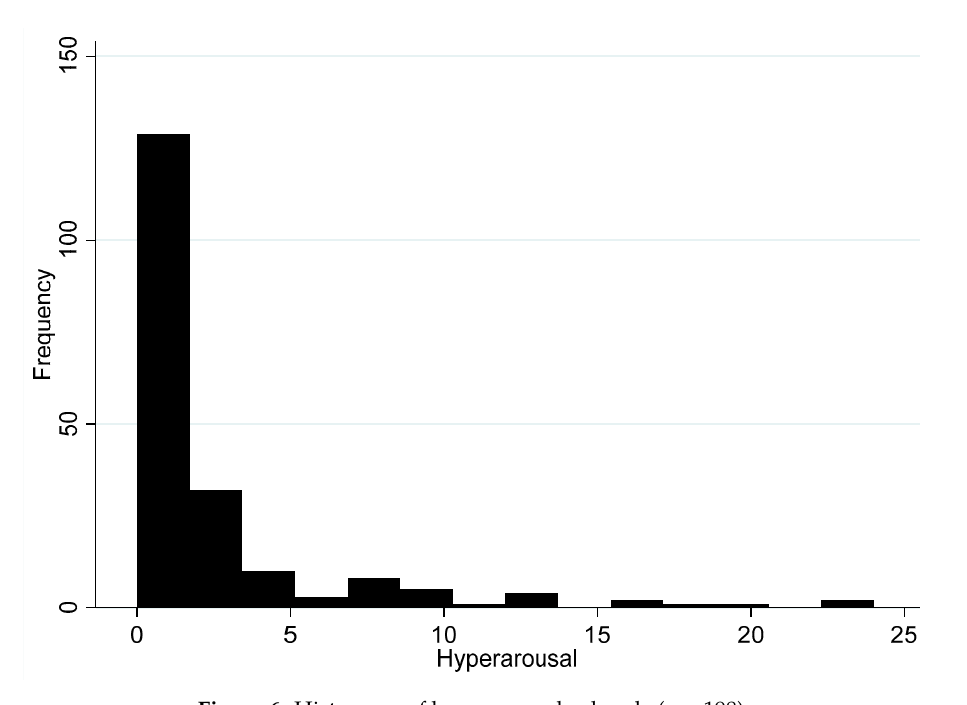
Figure 6. Histogram of hyperarousal subscale ( n = 198).